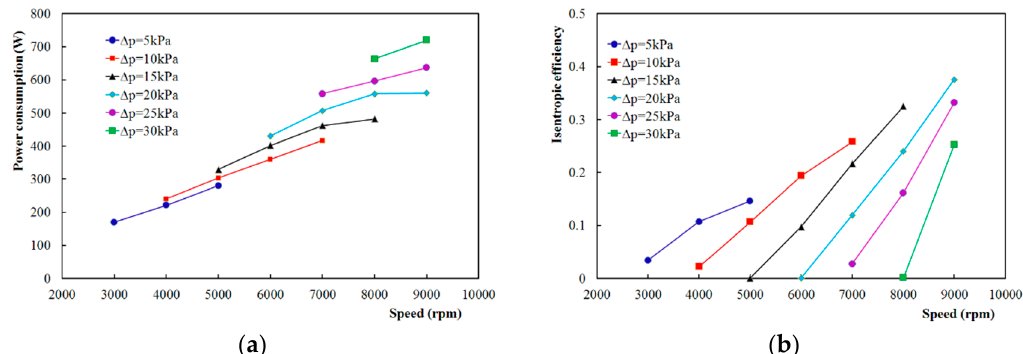
Figure 6. Effect of pressure difference on the performance: ( a ) power consumption; and ( b ) isentropic efficiency.